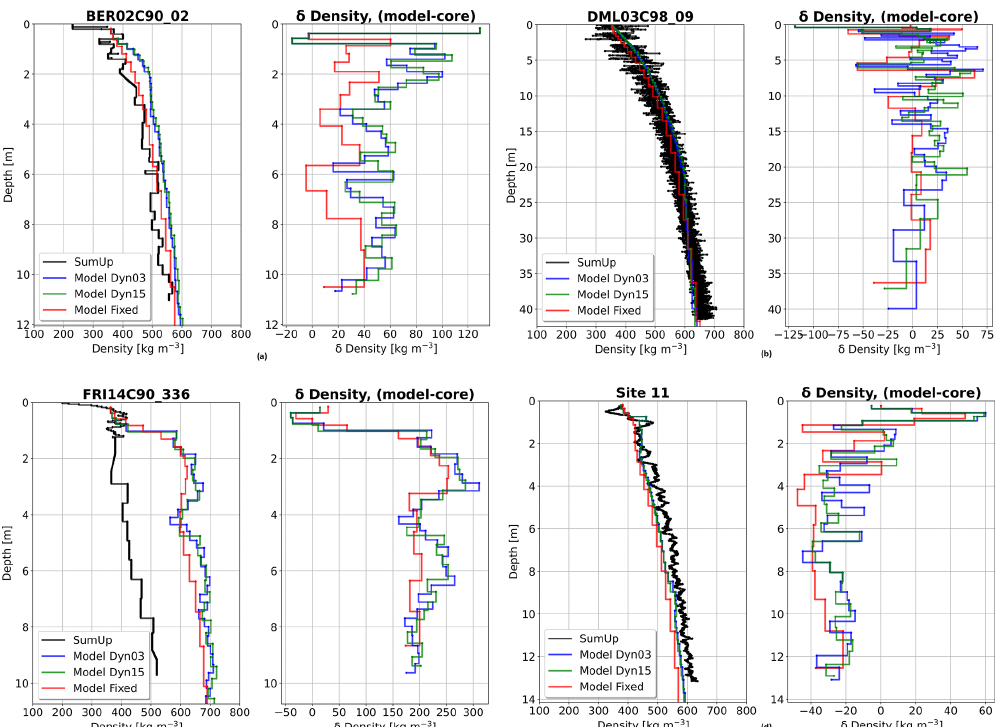
Figure 6. Examples of density profiles. In each of the four subfigures, the left-hand plot shows the firn core in black and the modelled density from Fixed, Dyn03, and Dyn15 in red, blue, and green. The right-hand plot shows the difference. The cores are (a) BER02C90_02 taken in 1990 (Wagenbach et al., 1994), (b) DML03C98_09 taken in 1998 (Oerter et al., 2000), (c) FRI14C90_336 taken in 1990 (Graf and Oerter, 2006), and (d) Site 11 taken in 2013 (Morris et al.,